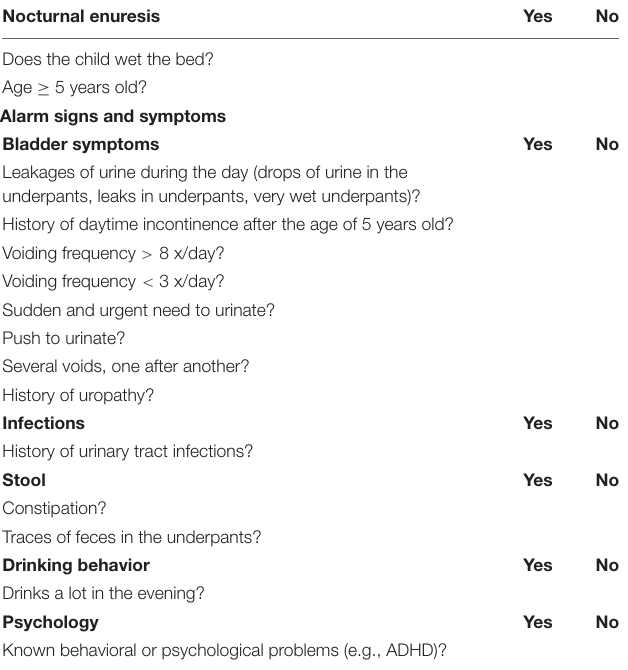
TABLE 1 | Questionnaire based on CMT (15). Nocturnal enuresis Yes No